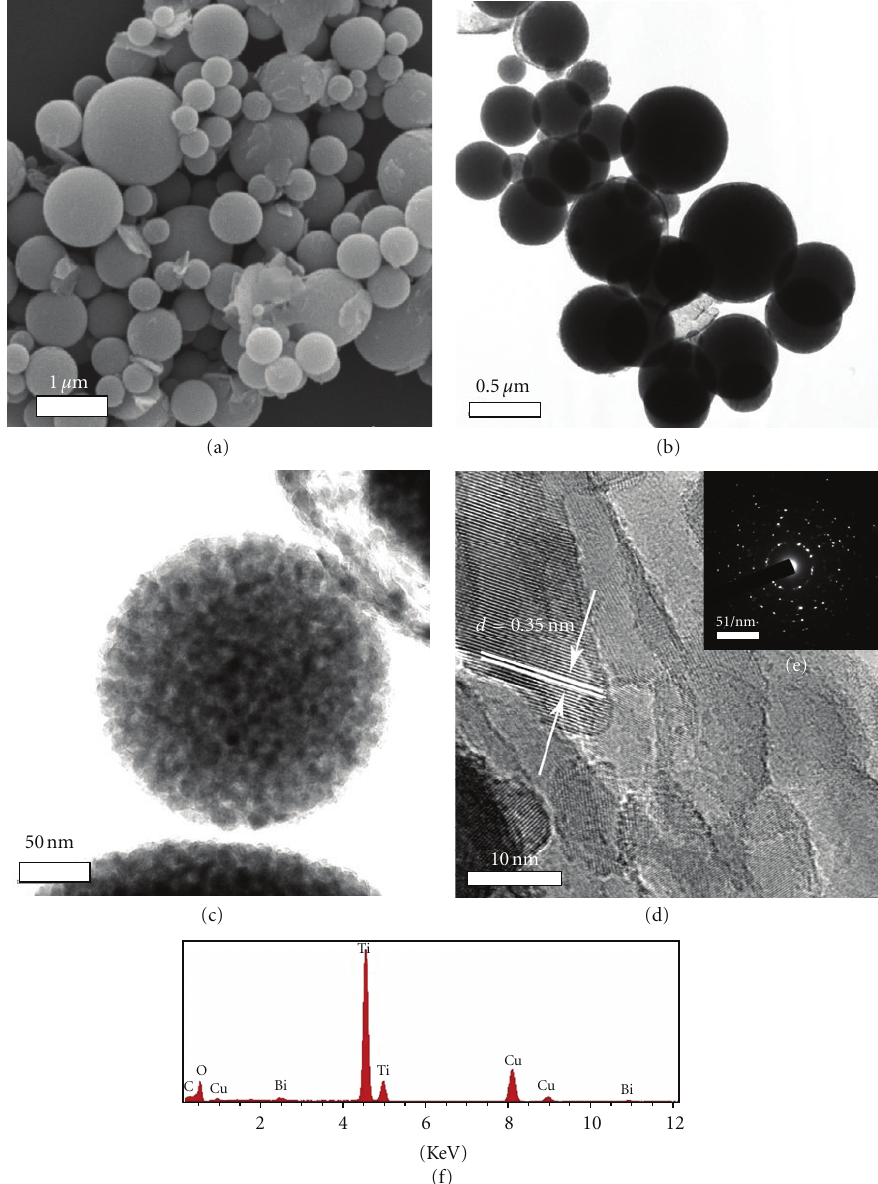
Figure 2: Representative structural characterizations and general morphologies of Bi-doped TiO 2 with 2% of Bi (a) SEM image, (b) and (c) TEM images, (d) HRTEM image, (e) SAED pattern, and (f) Energy-dispersive X-ray analysis